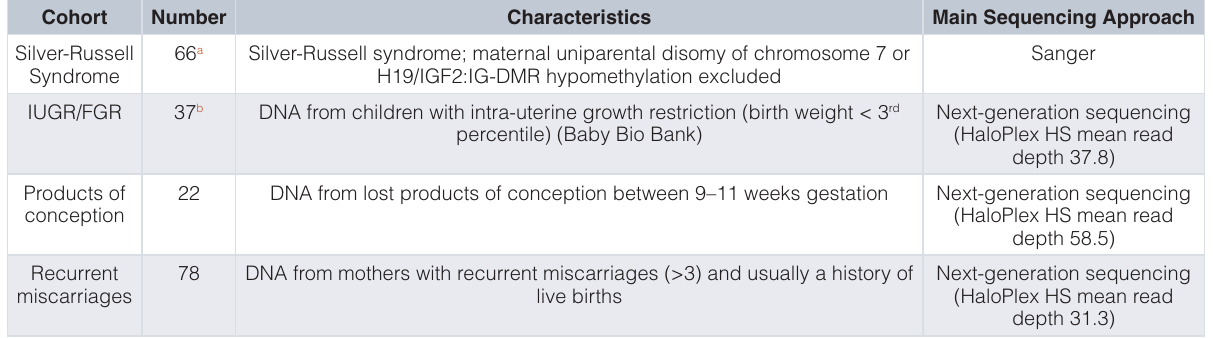
Table 1. Overview of the cohorts